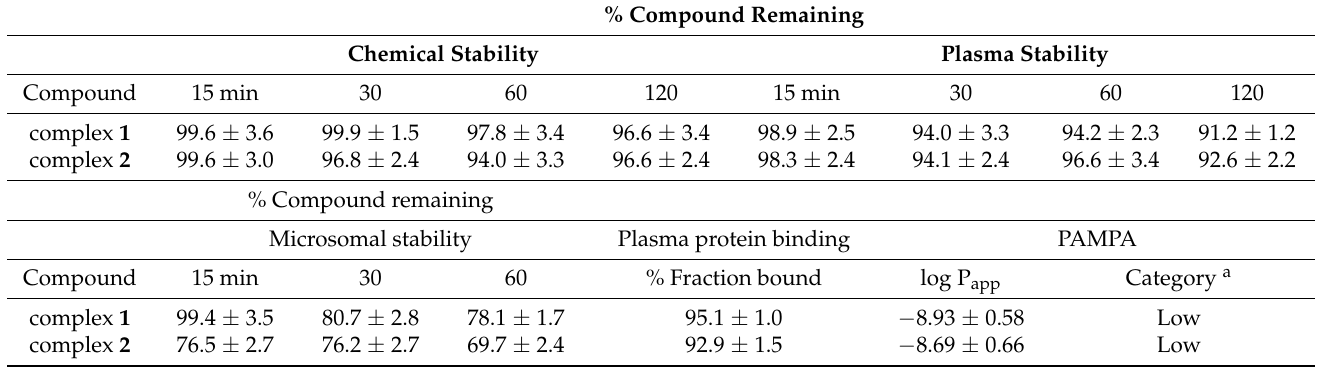
Table 3. Pharmacological parameters of the complexes 1 and 2